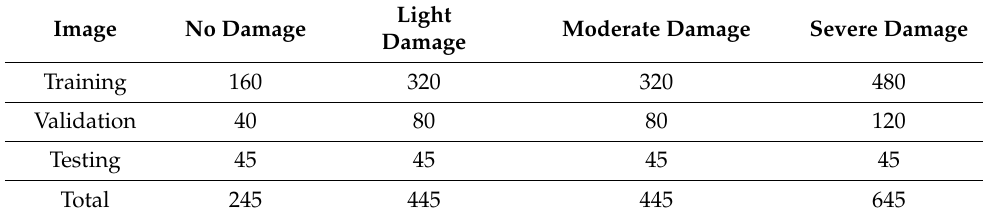
Table 2. Categorized summary of images in training, validation, and testing